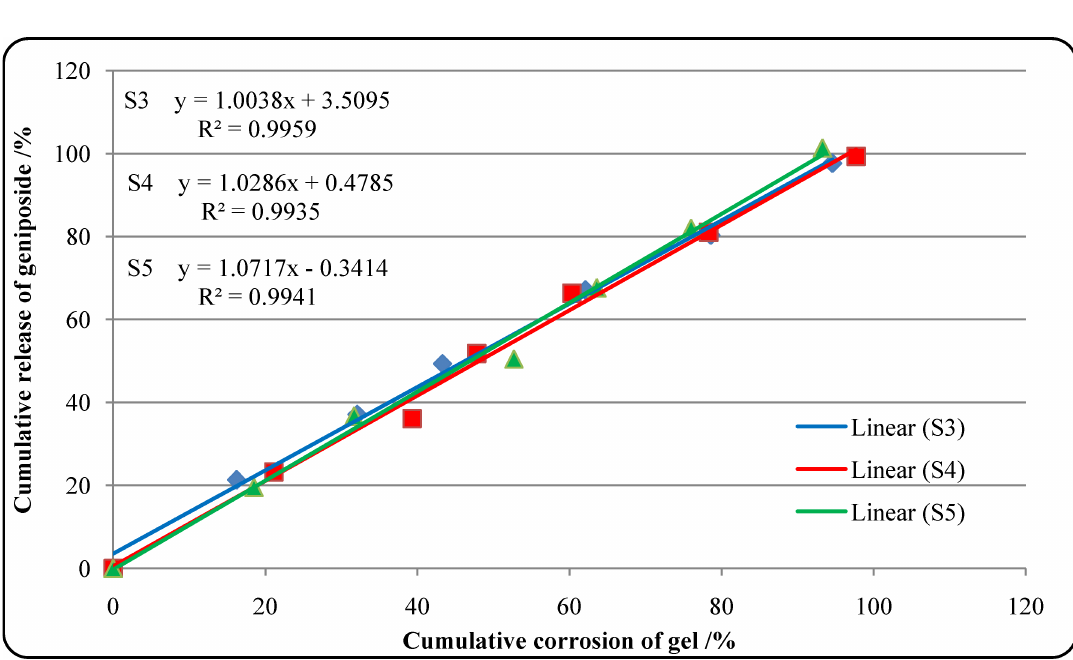
Fig 3. Releasekinetics of geniposide from the optimized formulations.